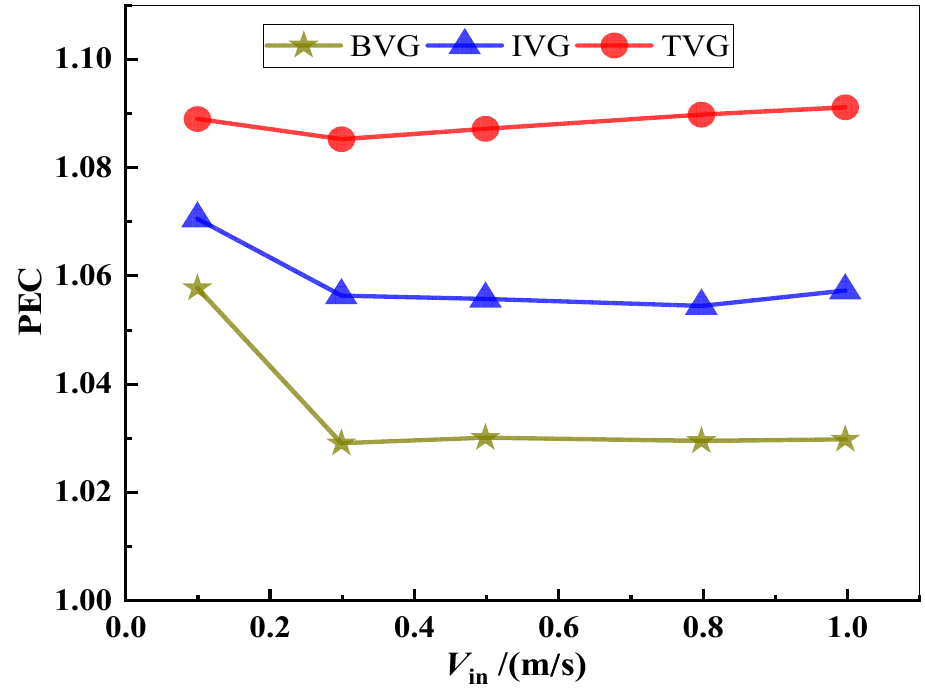
Figure 16. Influence of inlet flow rate on PEC of heat exchangers with vortex generators.